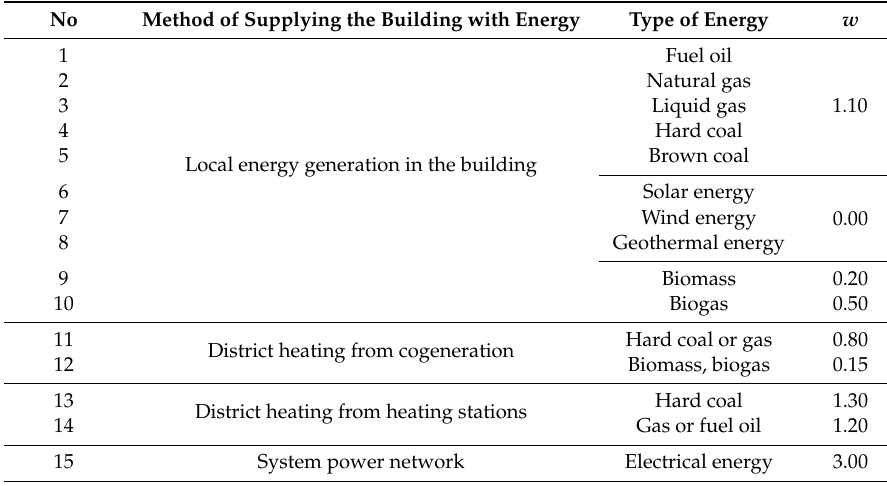
Table 1. The values of the non-renewable primary energy input factor on the generation and delivery of an energy carrier or energy for technical systems w